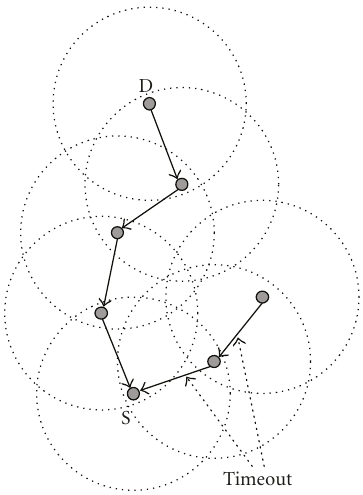
Figure 8: Reverse path formation.